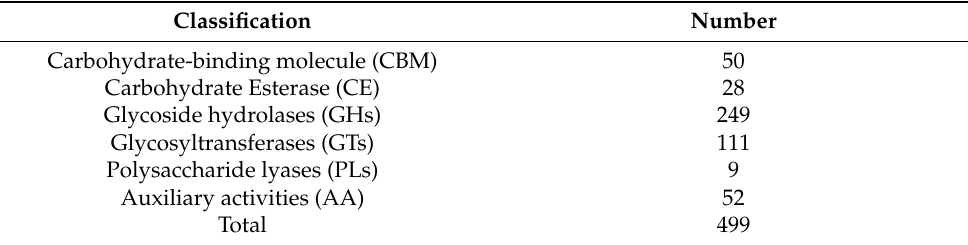
Table 4. Carbohydrate ‐ active enzyme annotation results of C. mycophilum BJWN07 . Classification